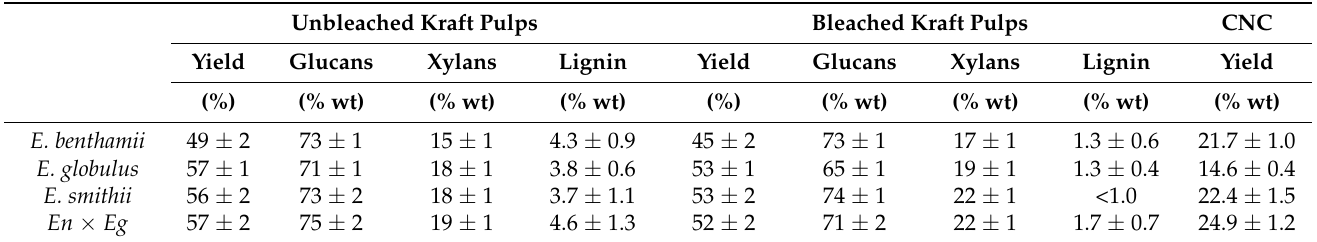
Table 1. Yield and composition of unbleached and bleached Kraft pulps along with CNCs obtaining yield from the different eucalyptus